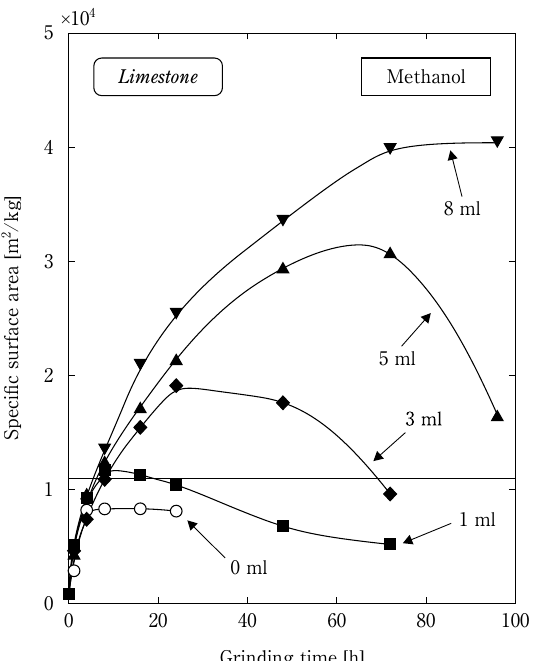
Fig. 2 Variations of specific surface area of limestone as a function of grinding time with the addition amount of methanol.